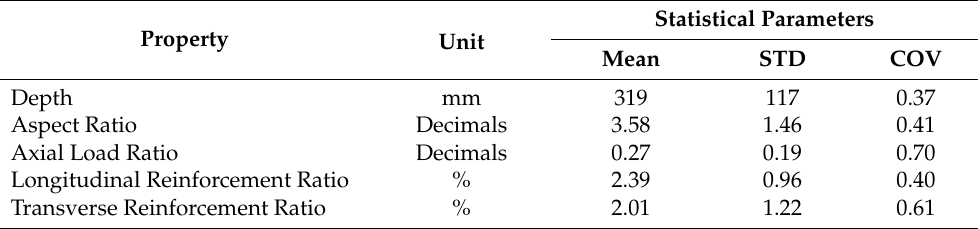
Table 1. Database